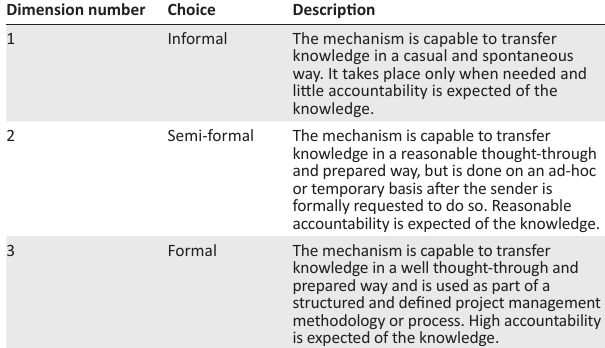
TABLE 6: Formalisation dimension. Dimension number Choice Description